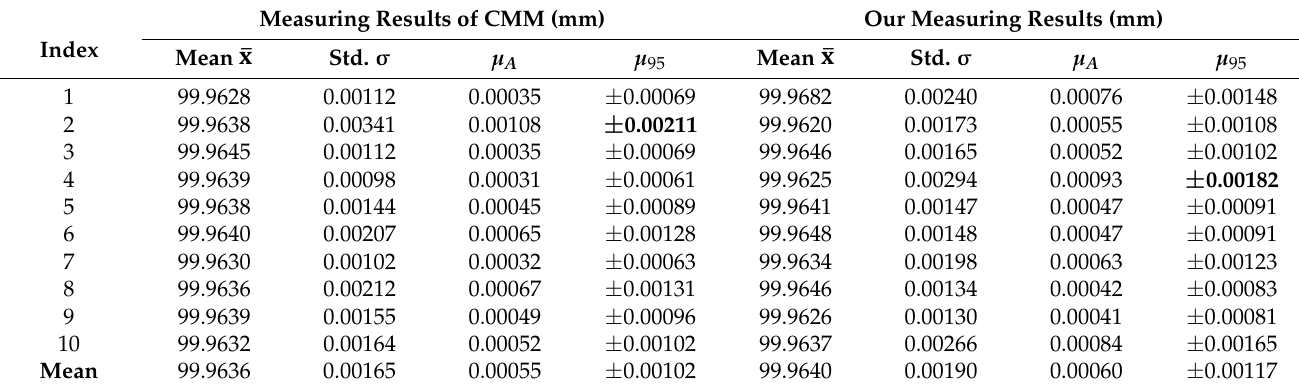
Table 6. The mean results of diameter measurements 10 times.